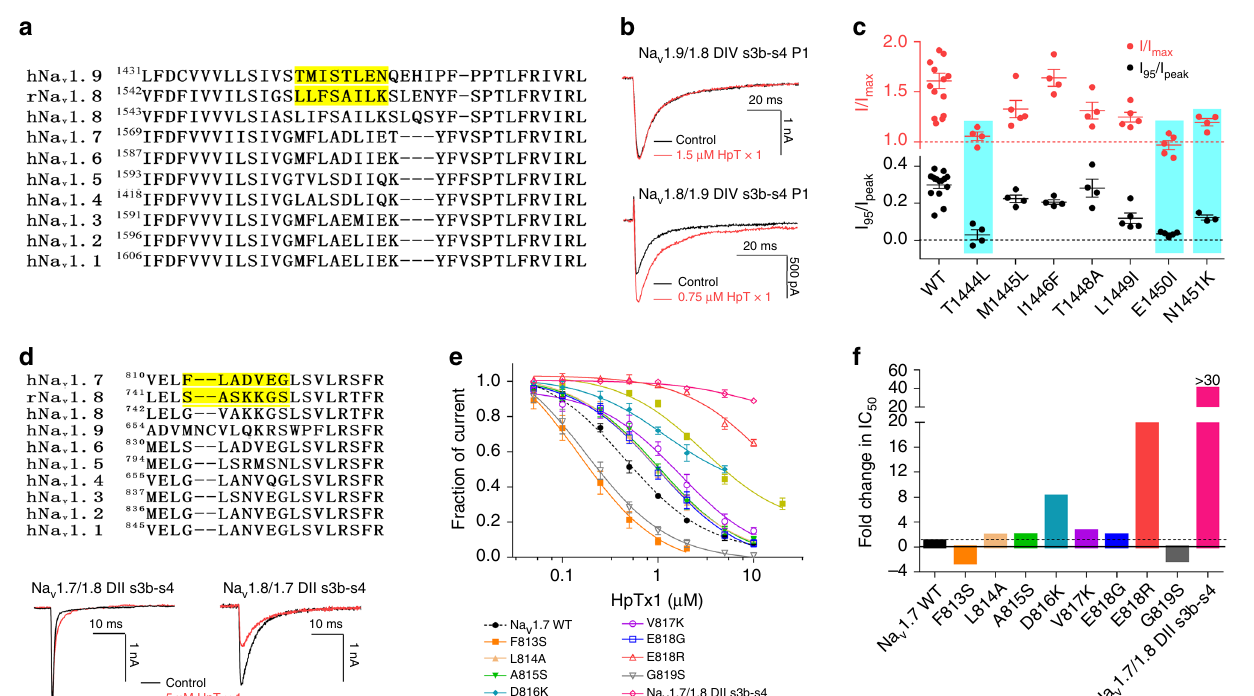
Fig. 6 The molecular mechanism of HpTx1 action on Na v 1.9 and Na v 1.7 channels. a Sequence alignments corresponding to the DIV s3b-s4 region of Na v subtypes. The highlighted sequences show the regions swapped between Na v 1.8 and Na v 1.9. b Representative current traces from Na v 1.9/1.8 DIV s3b-s4 P1 (top) and Na v 1.8/1.9 DIV s3b-s4 P1 (bottom) chimaera channels in the absence (black) and presence (red) of HpTx1. c Effects of HpTx1 on WT and mutant hNa v 1.9 channels. Dot plots display the effect of 0.75 μ M HpTx1 on the peak current (top, n = 14 for WT; n = 4 for T1444L, M1445L, I1446F, and T1448A; n = 5 for L1449I and E1450L; n = 3 for N1451K) and the persistent current (bottom, n = 14 for WT; n = 4 for T1444L, I1446F, T1448A, and N1451K; n = 5 for M1445L, L1449I, and E1450L). Key residues involved in the interaction between HpTx1 and hNa v 1.9 are labeled (one-way ANOVA with Dunnett ’ s multiple comparison test, I 95 /I peak : F (7,35) = 17.72, P < 0.0001; I/I max : F (7,38) = 8.157, P < 0.0001). d (top) Sequence alignments corresponding to the DII s3b-s4 region of Na v subtypes. The highlighted sequences show the regions swapped between Na v 1.7 and Na v 1.8. Representative current traces from Na v 1.7/1.8 DII s3b-s4 (bottom left) and Na v 1.8/1.7 DII s3b-s4 (bottom right) chimaera channels in the absence (black) or presence of 5 μ M HpTx1 (red). e Dose-dependent inhibitory curves show the effect of HpTx1 on WT ( n = 7) and mutant hNa v 1.7 channels ( n = 4 for F813S, n = 6 for L814A and A815S, n = 3 for D816K, n = 6 for V817K, n = 7 for E818G, n = 4 for E818R, n = 5 for G819S and n = 3 for Na v 1.7/1.8 DII s3b-s4) and the Na v 1.8/1.7 DII s3b-s4 chimaera channel ( n = 5). f Bars show the fold changes in IC 50 values of HpTx1 for mutant channels compared with that for the WT hNa v 1.7 channel. Data are presented as the mean ± S.E.M. Exact P ( c ) are presented in Supplementary Data 1. Source data are provided as a Source Data fi le.